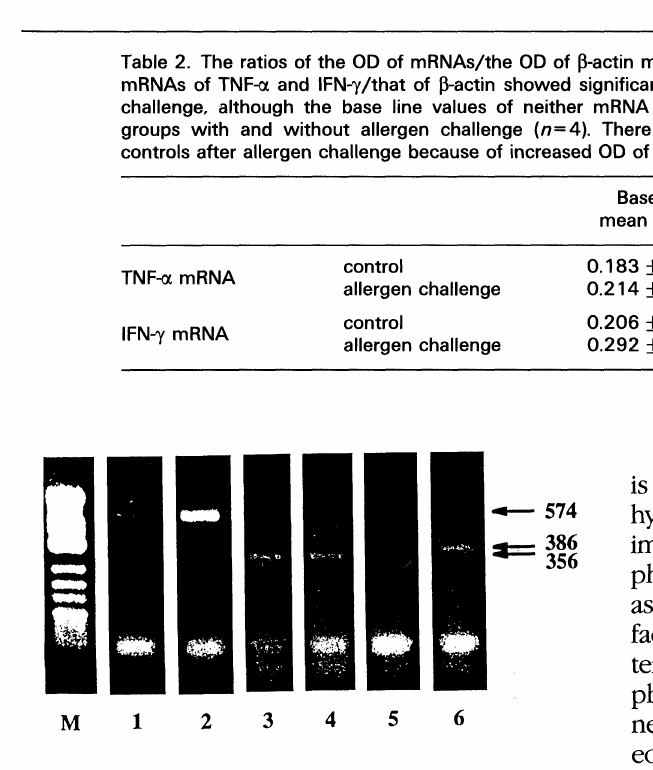
Table 2. The ratios of the OD of mRNAs/the OD of -actin mRNA in the nasal mucosa. The ratios of the OD of mRNAs of TNF- and IFN-7/that of -actin showed significant differences from the controls 3 h after allergen challenge, although the base line values of neither mRNA showed any significant differences between the groups with and without allergen challenge (n=4). There were decreases in the OD ratios of IFN-? and controls after allergen challenge because of increased OD of -actin mRNA.